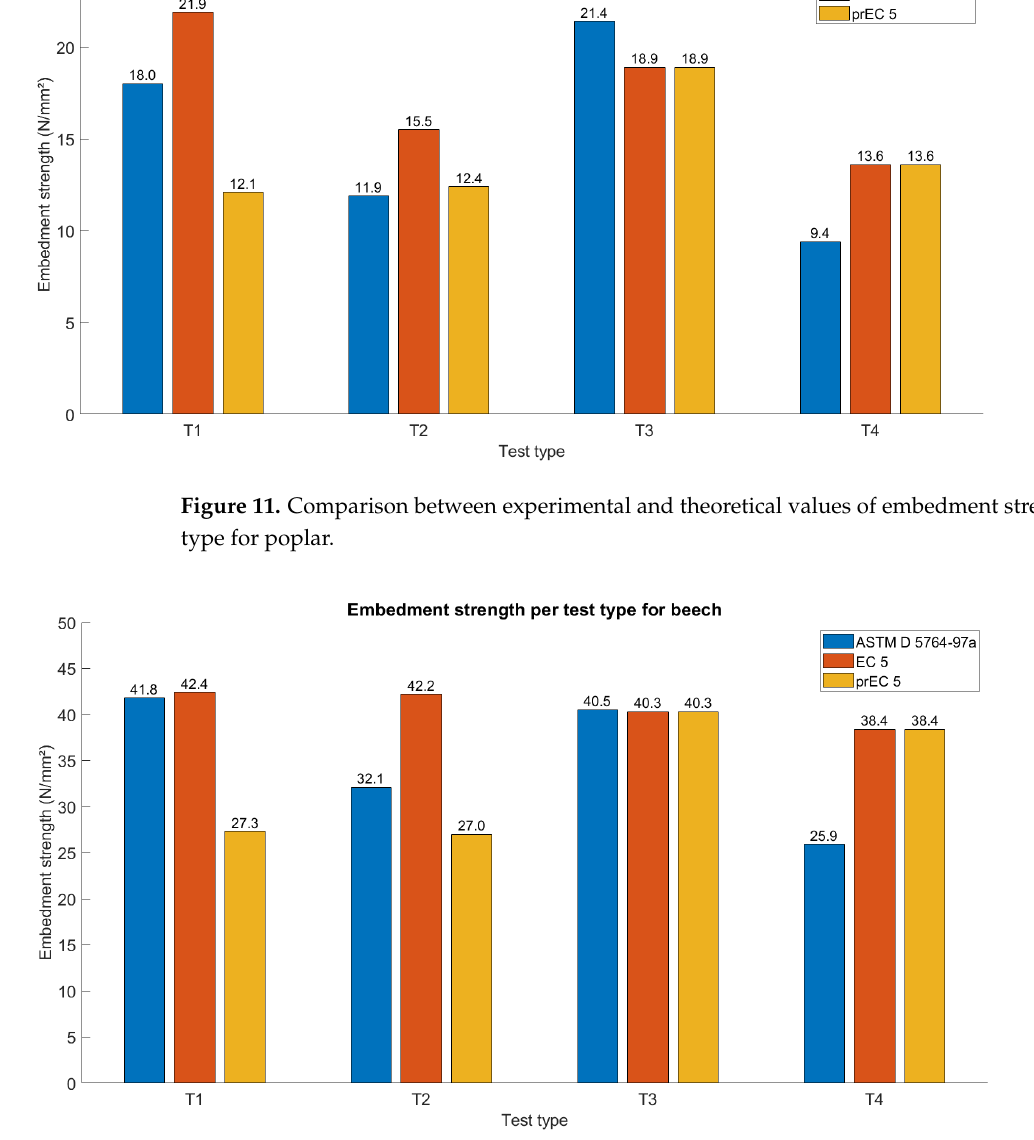
Figure 12. Comparison between experimental and theoretical values of embedment strength per test type for beech. Table 4. Ratios between theoretical values of embedment strength according to EC5 and prEC5 and experiment values according to ASTM D 5764-97a.